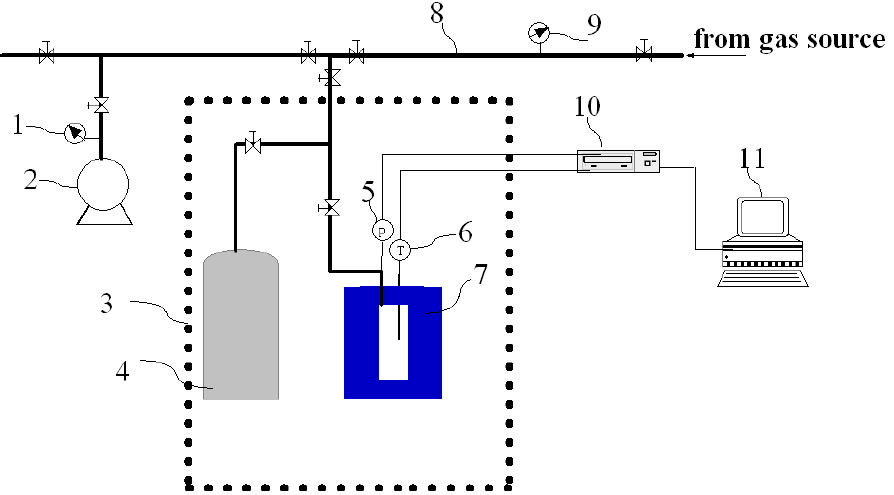
Figure 1. Experimental apparatus. 1 , vacuum pressure gauge; 2 , vacuum pump; 3 , air bath; 4 , buffer tank; 5 , pressure sensor; 6 , platinum resistance temperature sensor; 7 , stainless steel reactor; 8 , pipeline; 9 , pressure gauge; 10 , data acquisition instrument; 11 , computer. Table 1. Working parameters of the laser Raman spectrometer.